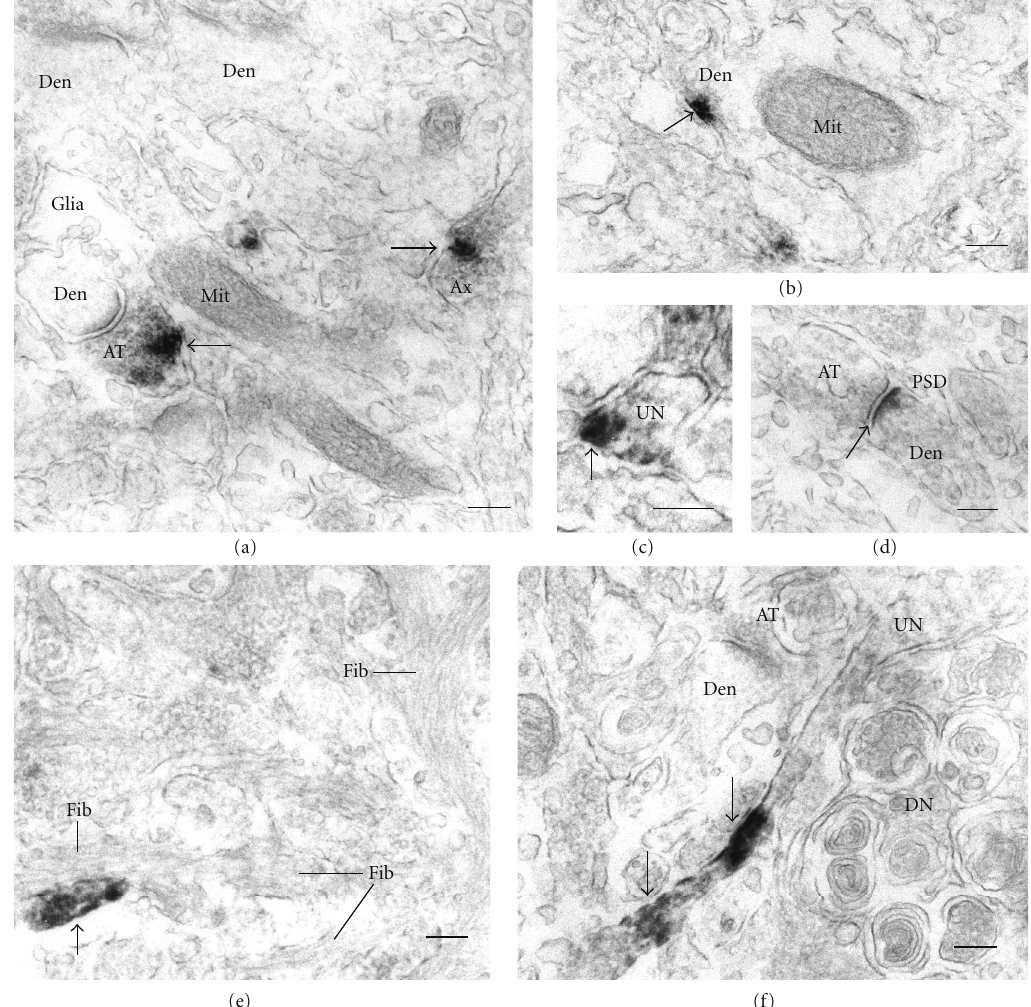
Figure 2: Ultrastructural localization of annular protofibrils (APFs) in aged NEP + / + APP + (a,c) and NEP − / − APP + (b,d–f) mouse brain sections. DAB method. (a) Anti-annular protofibril immunoreactions ( α APF-IRs) on synaptic vesicles in axon terminal (AT) and vesicles in axon (Ax). Den: dendrite, Glia: glial process, and Mit: mitochondria. (b,c) α APF-IRs on plasma membranes of dendrite (b) and unidentified process (UN) (c). (d) α APF-IR on postsynaptic density (PSD). (e,f) α APF-IRs were observed on plasma membranes and vesicles inside of cell processes (arrows) in senile plaques, but not on amyloid fibrils (Fib) and distended neurites (DN). Scale bar = 200 nm.